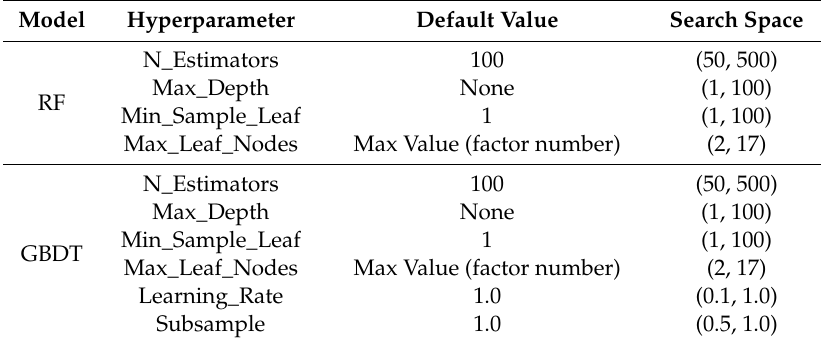
Table 2. Hyperparameters, default values and search spaces of random forest (RF) and gradient boosting decision tree (GBDT)